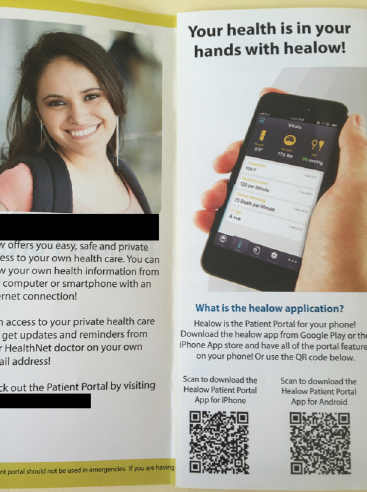
Figure 2. Example Patient Education